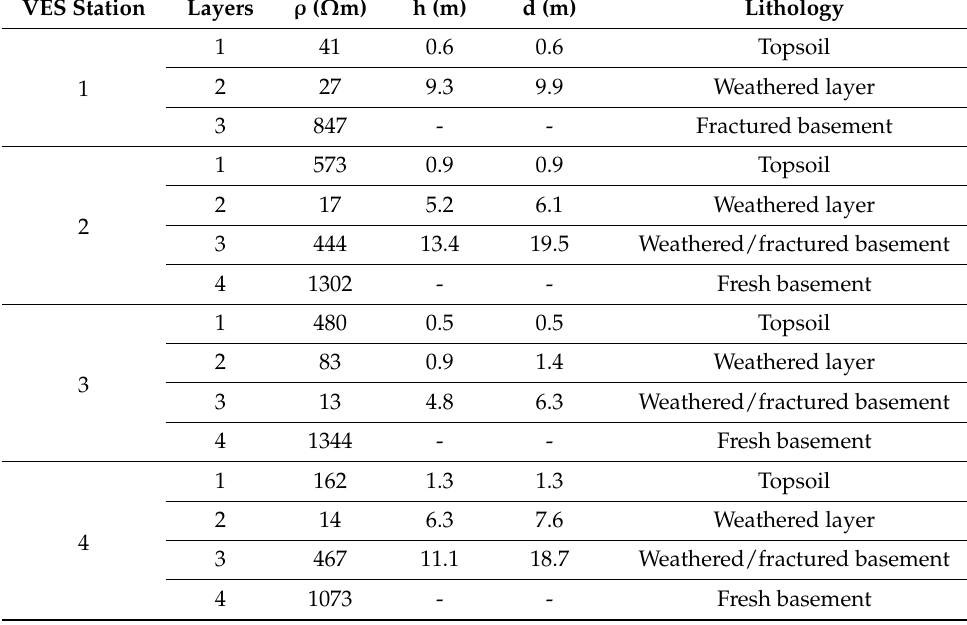
Figure 6. One-dimensional electrical resistivity sounding curves and models for VES 1 and 4 ( left ) and VES 2 and 5 ( right ). The model parameters, including the number of layers, resistivity, thickness, and depth, are shown to the right of each curve. Table 1. A summary of the 1D electrical sounding results at all six sounding stations with the numbers of layers, resistivities, thicknesses, and depths extracted from the model results. The lithology was interpreted based on a comparison with the lithology from well logs.